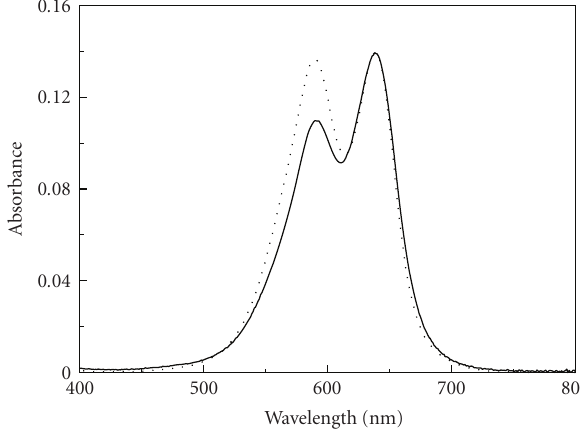
Figure 4: Absorption spectra of PAH-Cy5 A with dye label degree of 1:1500 (solid line) and 1:840 (dotted